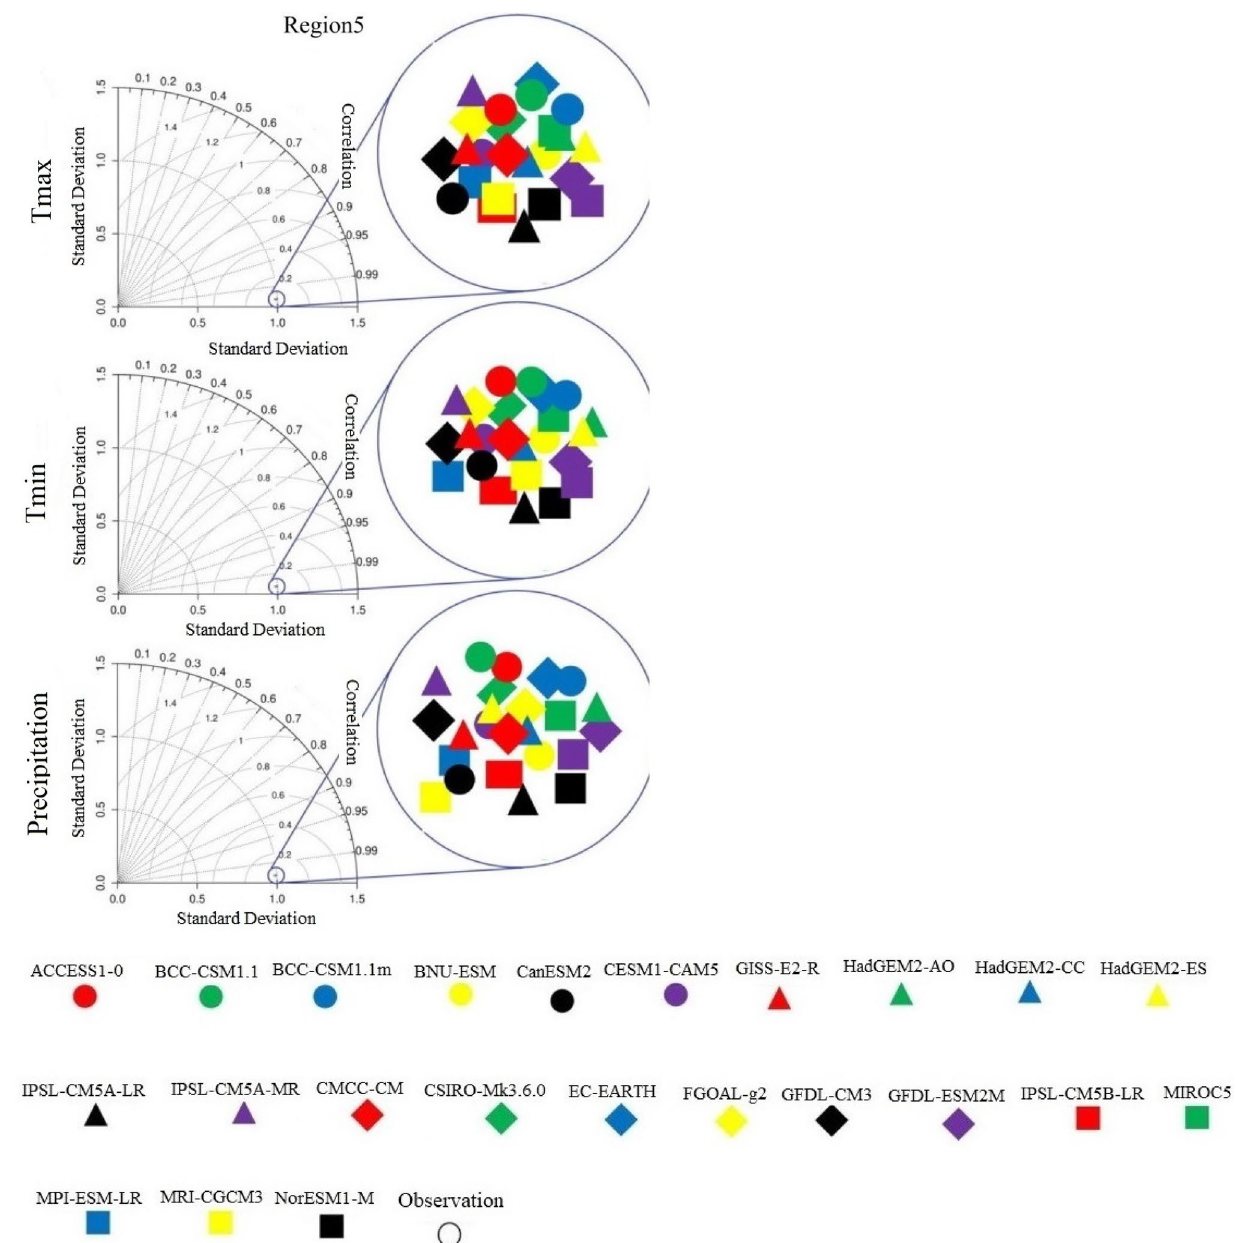
Fig. 17 Taylor diagrams for PCP, Tmax, and Tmin in region 5 in the baseline period